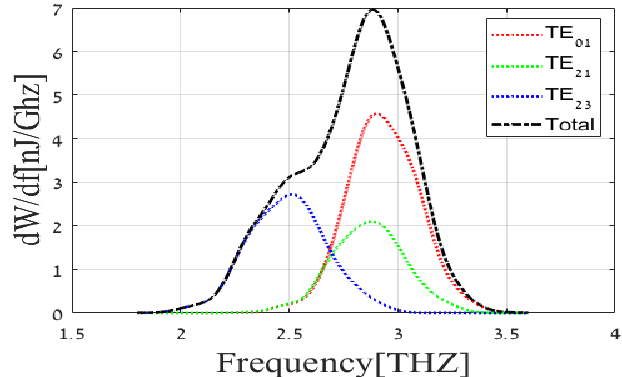
Figure 3. Output amplitude radiation spectrum of Israeli free-electron THz source.